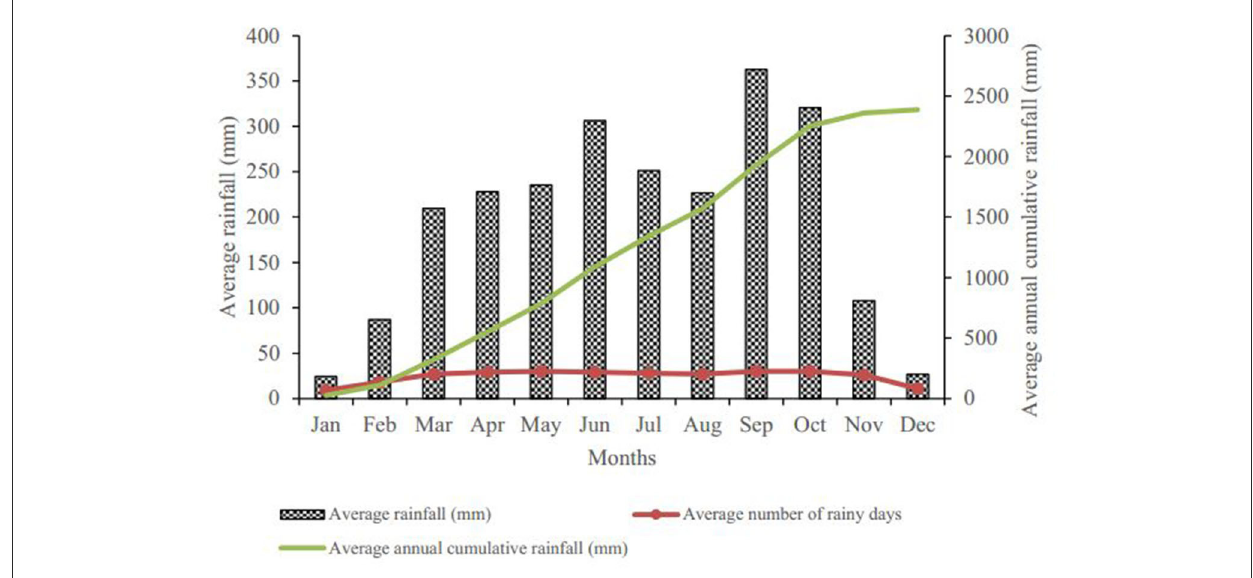
FIGURE1 Average monthly rainfall amount and rainy days of the study site (2009–2021).